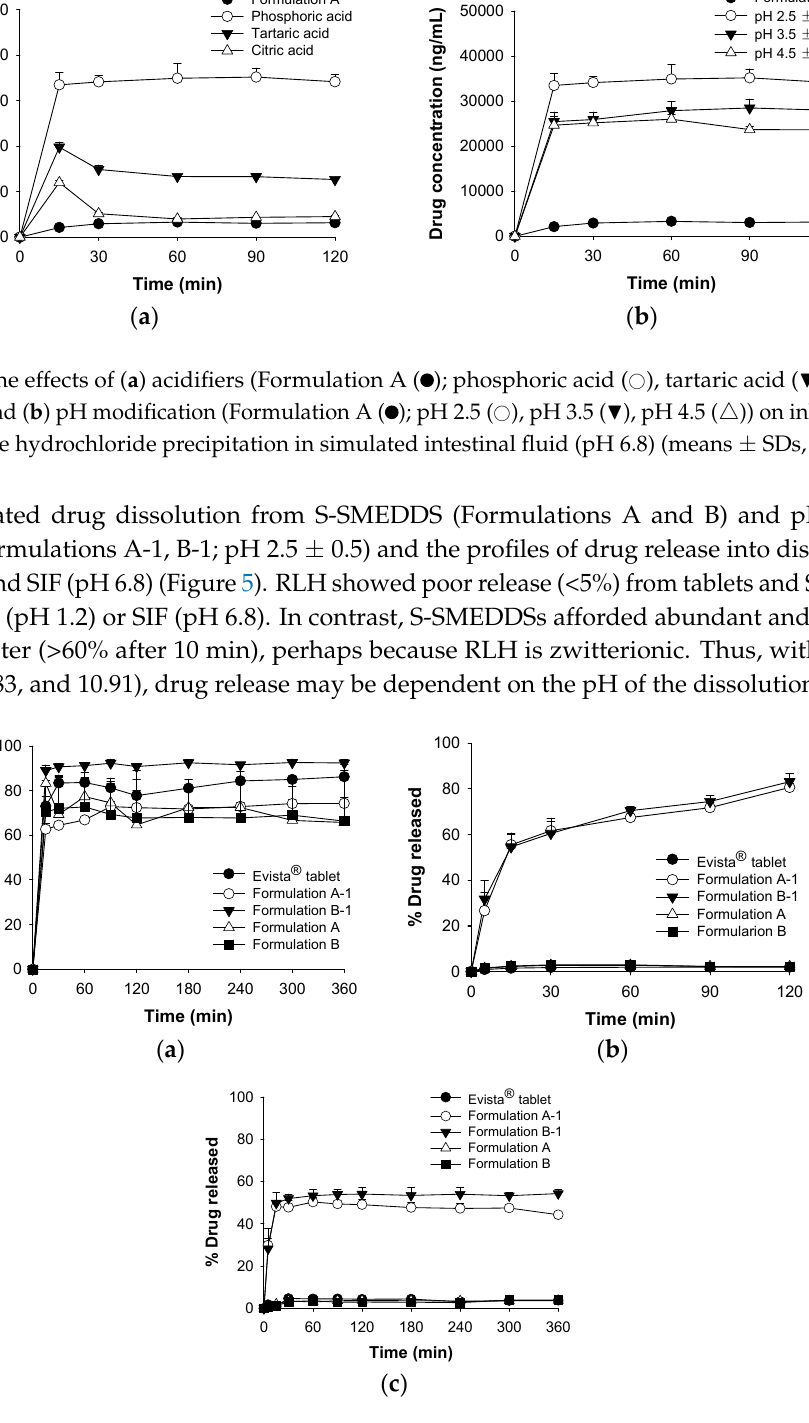
Figure 5. Dissolution profiles of raloxifene hydrochloride contained in Evista ® tablets ( ● ) ((Formulations A ( △ ), A-1 ( ○ ), B ( ■ ), and B-1 ( ▼ )) acidified to ( a ) pH 2.5 using phosphoric acid in distilled water; ( b ) simulated gastric juice (pH 1.2); and ( c ) simulated intestinal fluid (pH 6.8) (means ± SDs, n = 3).